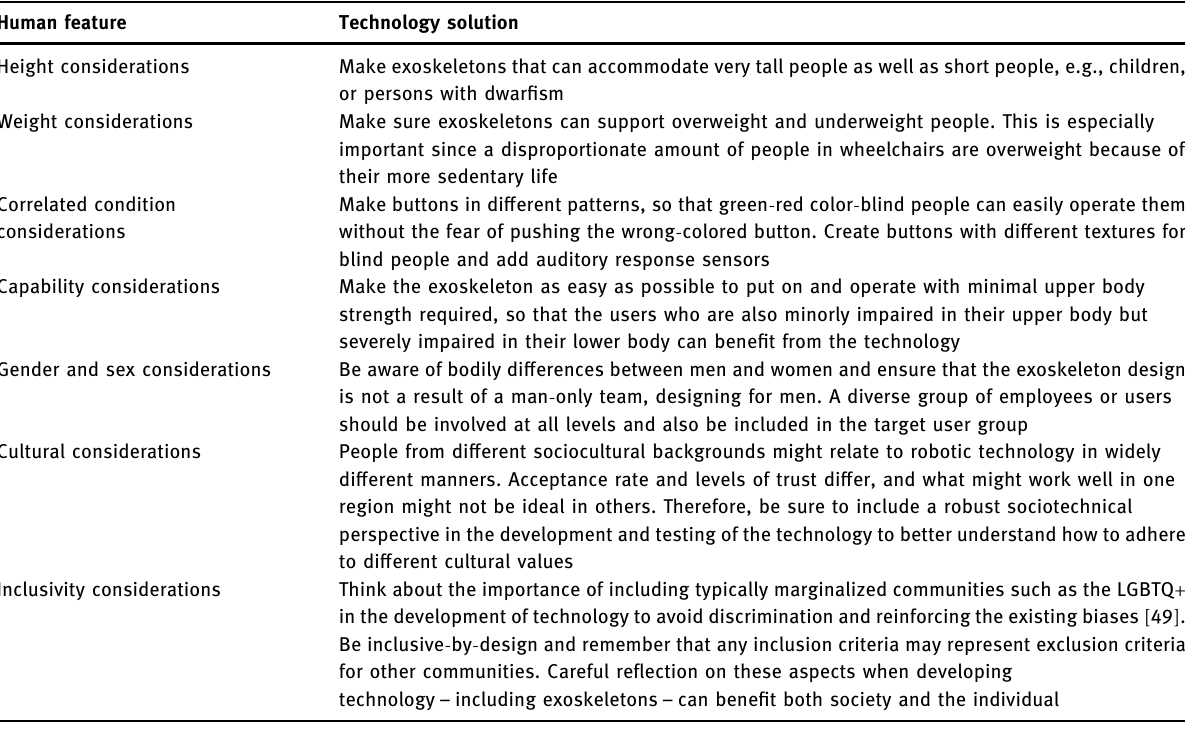
Table 2: Inclusive design choices for exoskeleton design Human